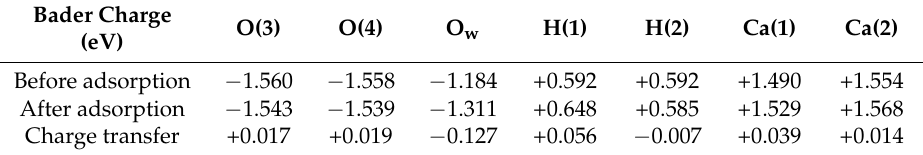
Table 5. Bader charge (eV) of bonding atoms before and after water adsorption from